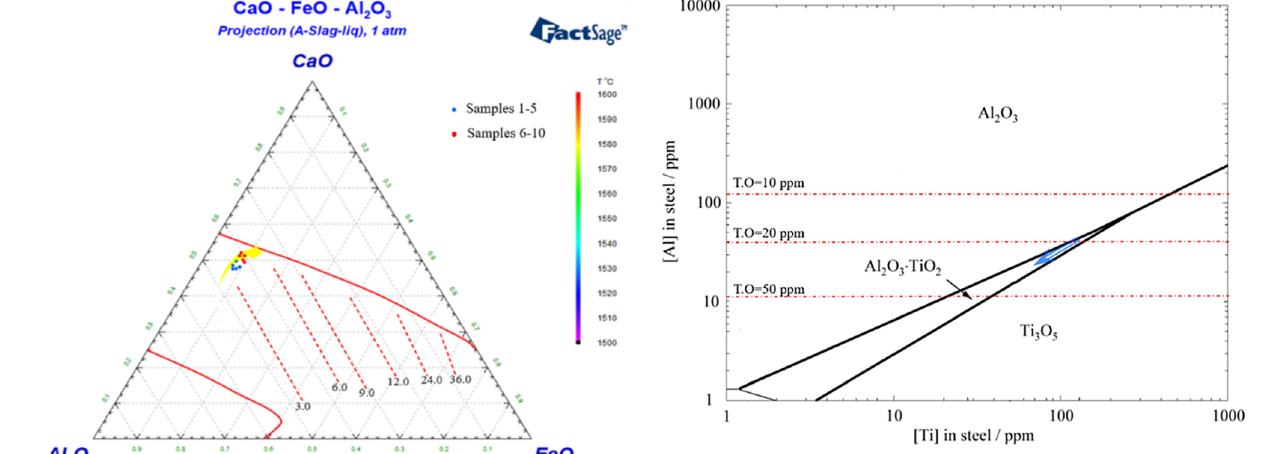
Figure 10: The Δ C/ η isoline diagram of FeO – CaO – Al 2 O 3 – 5% SiO 2 – 7% MgO fi ve - element slag system at 1,600°C.